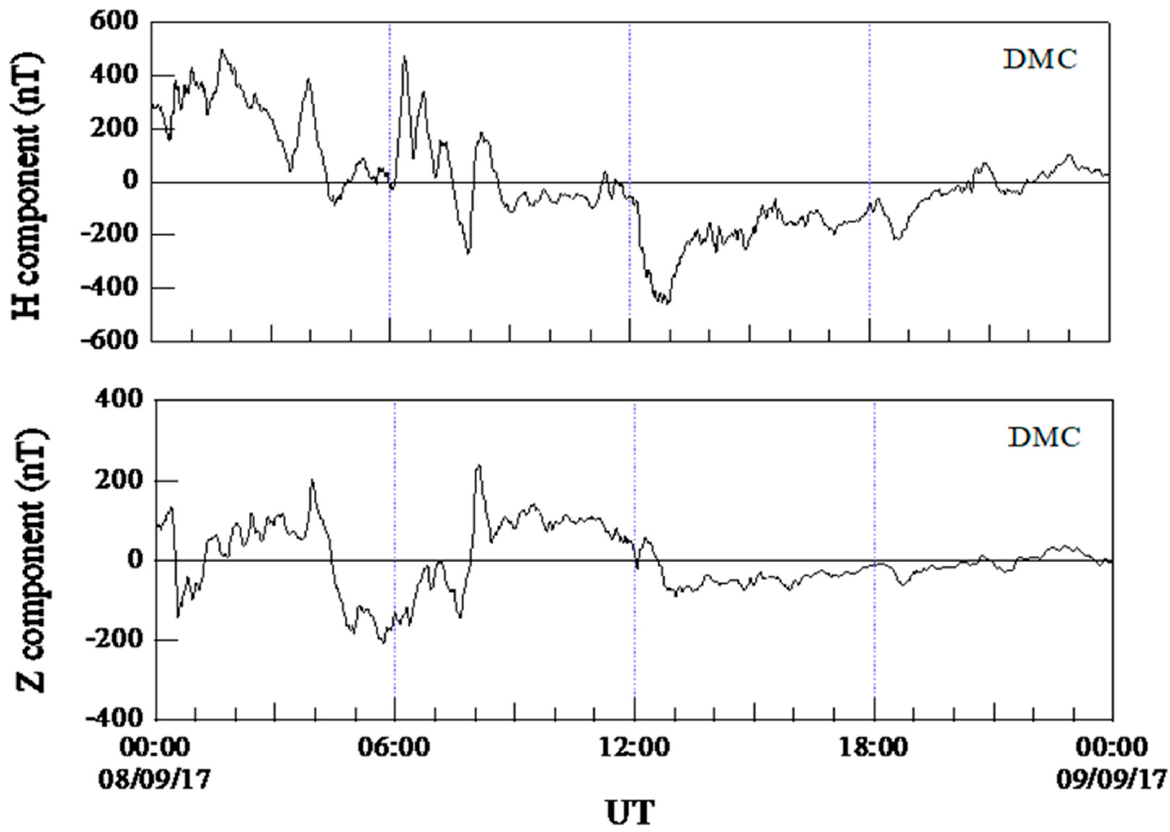
Figure 12. H and Z magnetic field components recorded at DMC magnetic station at Concordia on 8 September 2017. Finally, Figure 13 shows the isocontours of the ionospheric potential (red = positive; blue = negative potential) derived from SuperDARN measurements along with the location of measurements themselves (black squares) recorded in the two minutes following the time shown at the top of each map. In each map the projection to 350 km of altitude of all the σ ϕ values, which have elevation angle α = 30 ◦ (purple circles), recorded in the same time interval as for SuperDARN observations by the GNSS receiver at Concordia, are also shown. In all maps, the location of the GNSS receiver’s field of view (purple circles) with respect to the configuration of the ionospheric potential cells suggests that amplitude scintillations occurred in the ionospheric region between the two convection cells. Such region is well-known to be characterized by fluid and magnetohydrodynamic turbulence in ionosphere or in magnetosphere, which map to the ionosphere [62,93,94], which is able to generate small-scale irregularities. In addition, inside the GNSS receiver’s field of view (purple circles) SuperDARN recorded echoes back from the ionosphere, confirming the presence of irregularities whose spatial scale is well below the L-band Fresnel scale